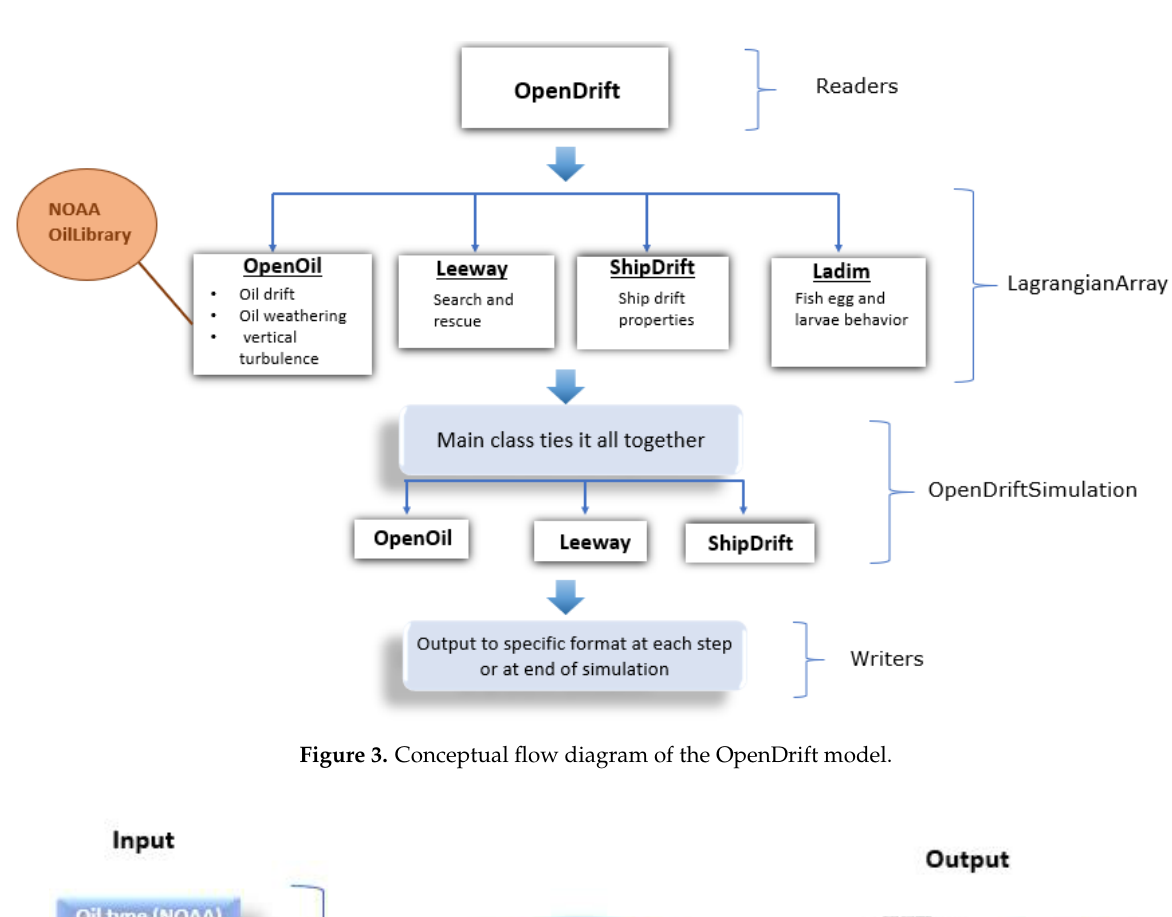
18 of 39 Figure 2. Schematic diagram of MEDSLIK-II model with input and output data. The model has the following extra features: it incorporates a built-in oil database (from REMPEC [259]) with over 220 oil types which are widely used in the Mediterranean and the Black seas; it has been applied to forecast oil spill fate and transport during nu- merous emergency cases in the Mediterranean Sea (Lebanese oil pollution crisis in 2006, Und Adriyatik in 2008, and the Costa Concordia emergency in 2012). The sensitivity of the oil spill predictions to several model parameterizations is examined and the outputs are validated by means of surface drifters, SAR (synthetic aperture radar), and optical satellite images. Due to a vast range of parameters that handle the oil movement and transformation in MEDSLIK-II, recently, implemented straightforward and effective algorithms to evalu- ate uncertainties may resulting from the initial oil spill conditions [179], ocean currents, and winds [174]. The oil drift module OpenOil is based on the open source [260], python-based, tra- jectory framework of OpenDrift [205], and it is a newly-integrated oil spill transport and fate model [112]. A conceptual flow diagram of the OpenDrift model is included in Figure 3. OpenOil (Figure 4) has been implemented operationally in Norway, as an oil spill con- tingency and search and rescue model [261,262] and for drifter and oil slick observations in the North Sea [112,263]. MET Norway uses in-house high-resolution ocean circulation and meteorological models as forcing for providing operational oil spill forecasts with OpenOil. If needed, coarser resolution forecasts from CMEMS for hydrodynamics and ocean state and NOAA’s GFS for wind fields can be also used. This model integrates al-